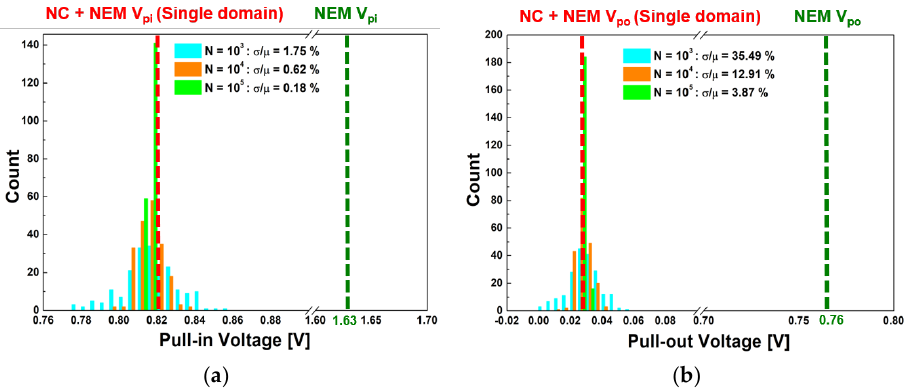
Figure 5. Distribution of ( a ) pull-in voltage and ( b ) pull-out voltage for an NEM relay, NEM relay with a single-domain ferroelectric and 200 samples of an NEM relay with a multi-domain ferroelectric. Variation of pull-in/-out voltage increases as the number of domain decreases.